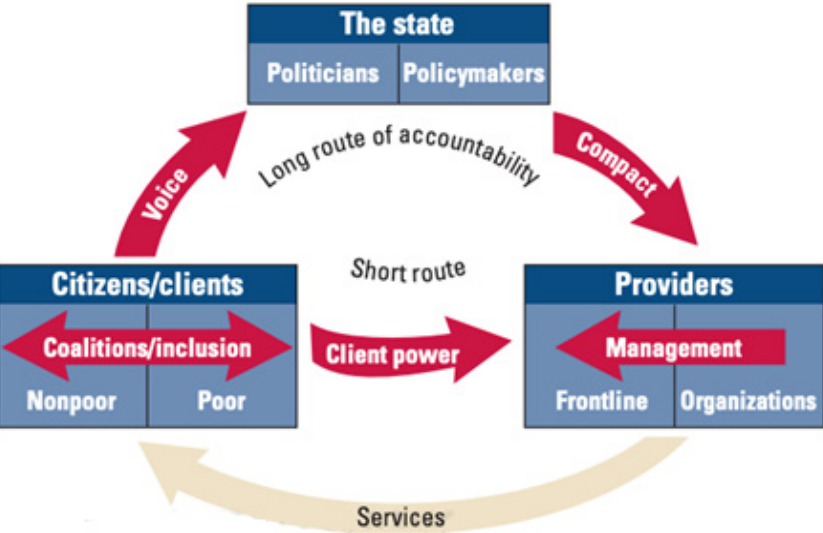
Figure 1. Key relationships of power and accountability, as introduced in the WDR 2004 report